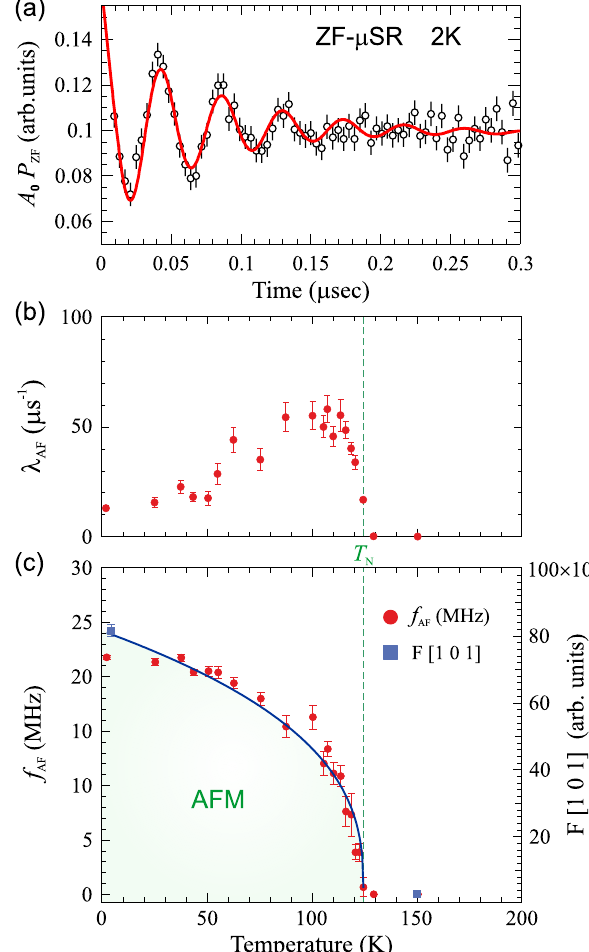
Figure 2. ( a ) Early time domain µ + SR spectra in zero field (ZF) at base temperature. The solid line is a fit to the function in Eq. (2). ( b ) Temperature dependence of the depolarisation rate ( (cid:31) AF ) of the antiferromagnetic signal. ( c ) Temperature dependence of the muon spin precession frequency ( f AF ). The blue solid line is a fit of f AF (T) to the mean field theory power law in Eq. (3). The integrated NPD intensity ( F ) of the purely magnetic Bragg peak 1 0 1 at base temperature and above the transition, respectively, are also plotted for comparison (see also text/ figures in the “XRD and NPD results” subsection